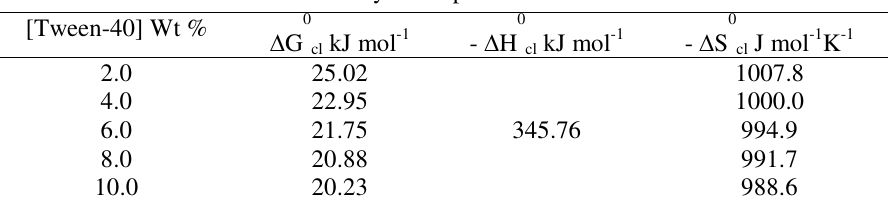
Table 2. Thermodynamic parameters of Tween-40